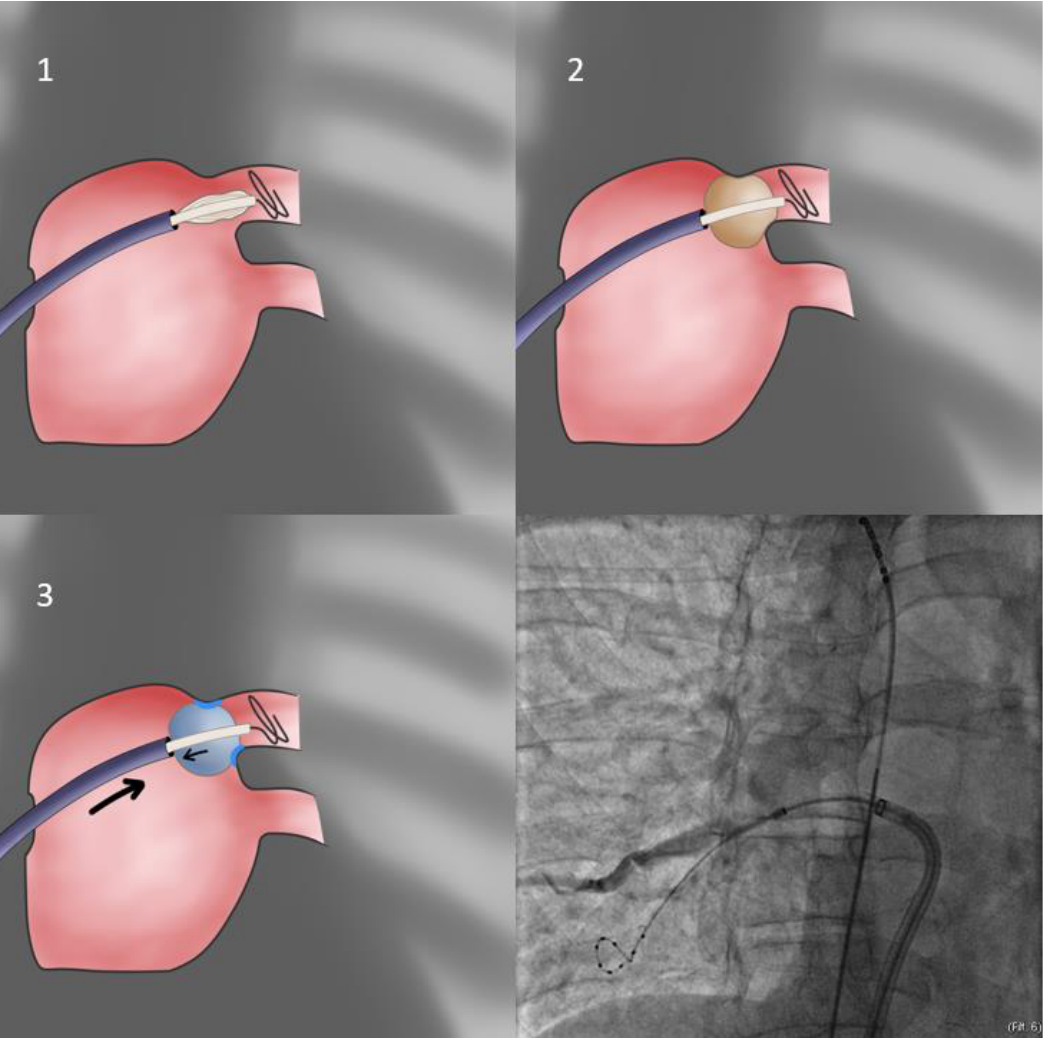
Figure 5. Trap-based approach. This is the most refined approach, mostly used for right inferior vein occlusion, although in principle, as shown, it can be used for all cases where achieving proper alignment of the catheter/balloon system with the pulmonary vein antrum is challenging. Thus, the operator attempts to use the pulmonary vein itself as a means to impart the proper alignment to the system by inflating the balloon slightly inside the vein. Then, as the balloon is ejected (care must be taken not to cause venous wall rupture by inflating too distally or by allowing for the fully pressur- ized balloon to dwell too long inside the vein — if not spontaneously ejected the balloon must be withdrawn). Then the closely positioned catheter sheath is promptly used to trap the balloon into place, which usually leads to adequate sealing of the vein. Again, it is emphasized that prior to inflation, proper orientation in the anterior/posterior plane must have been achieved, using the con- tralateral oblique projection. contralateral oblique